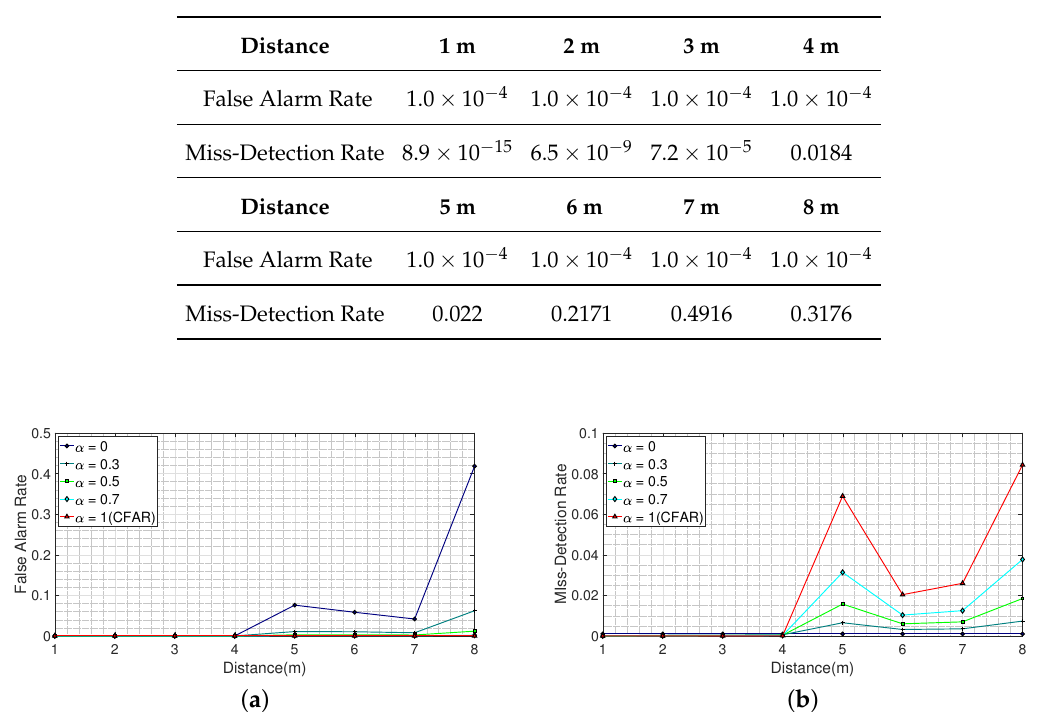
Table 10. Performance analysis in a heavy clutter environment when P Fa = 10 − 4 , P Md = 10 − 3 , α = 1 (constant false alarm rate algorithm (CFAR) algorithm).